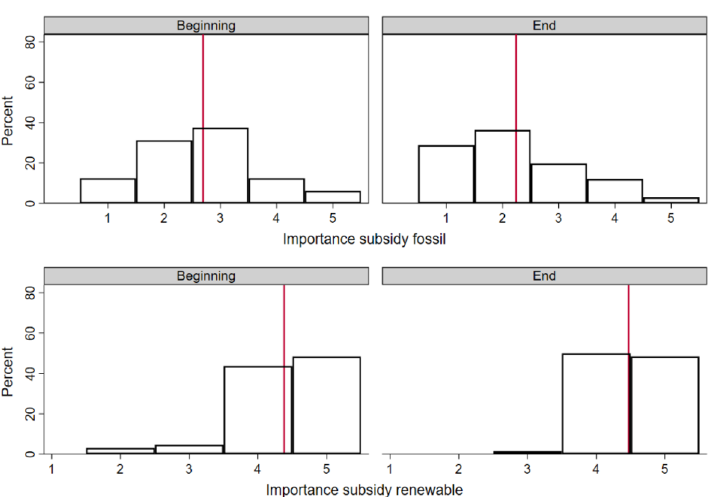
Figure 4. Distribution of responses on the importance of subsidies for the production of energy from fossil or renewable sources. Red lines represent the mean values of 2.7 (beginning) and 2.2 (end) for energy from fossil sources and 4.4 (beginning) and 4.5 (end) for energy from renewable